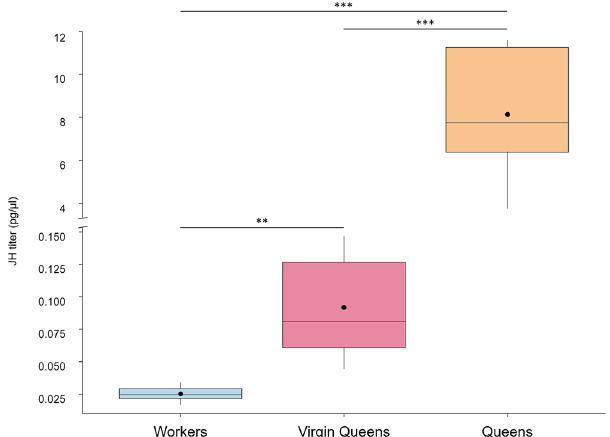
Figure 4. Juvenile hormone titers support a gonadotropic effect in common wasp queens. Circulating JH levels in pg/ μ l are 88 times higher in mature, egg-laying queens than in non-reproductive virgin queens, and 325 times higher than in nonreproductive workers (black circles and whiskers = averages and 95% confidence intervals calculated on a log scale and then backtransformed to the original scale, boxes = quartiles, horizontal bars = medians, n = 5 per group, but using pools of 5 individuals per sample for the workers; significance levels based on Anova and Tukey posthoc tests performed on log transformed data: ** p < 0.01, *** p < 0.001).